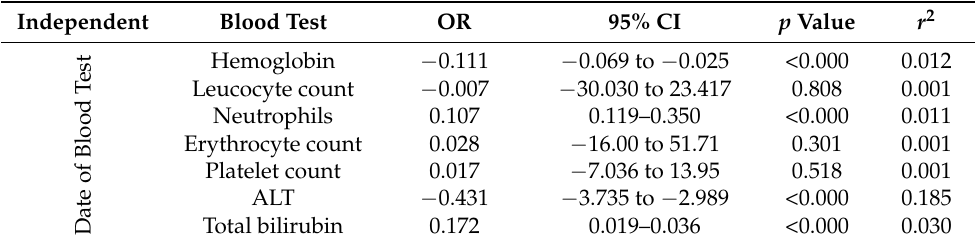
Table 3. Regression analysis presenting odds ratios with confidence intervals and the level of significance when testing to estimate the effect that treatment duration had on dependent variables (hematological